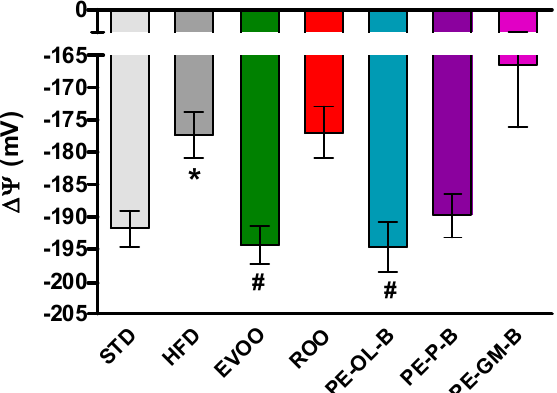
Figure 6. Changes in mitochondrial membrane potential in the di ff erent groups. * indicates a statistically significant di ff erence between the HFD group and the STD group. # indicates statistically significant di ff erence vs. HFD. Single symbol corresponds to p < 0.05.